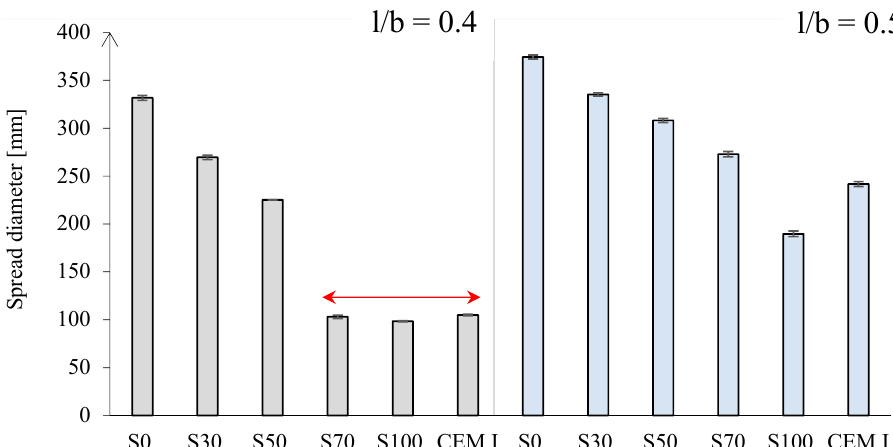
Figure 4. Mini-slump spread diameter of alkali-activated pastes and CEM I 42.5 N paste for l/b = 0.4 ( left ), and l/b = 0.5 ( right ).